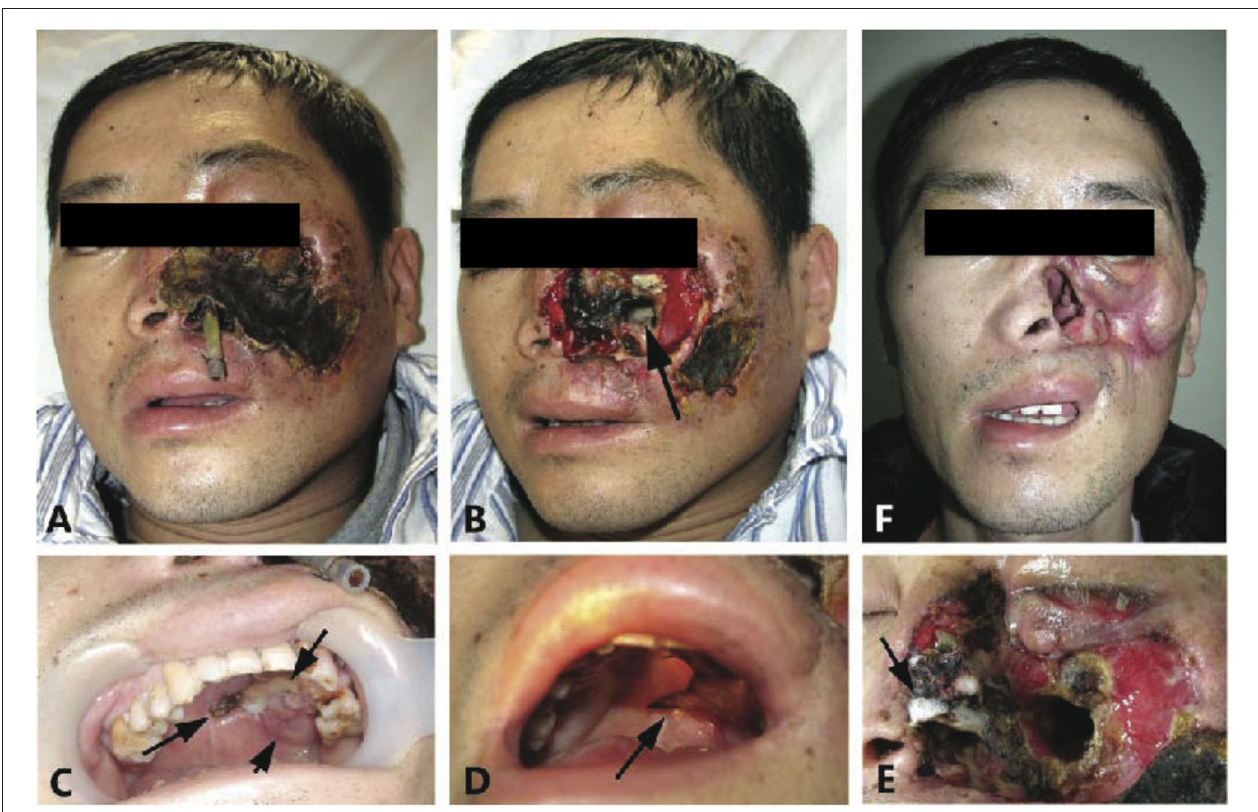
FIGURE 1 | “ Rhizopus arrhizus associated lethal midline granuloma/rhino-orbital cerebral mycosis.” Destruction of the sinus, nose, face, palate, and orbit; defects of the left sided external nose, soft tissues, and the front wall of the maxillary sinus; and yellow pus was seen within the left maxillary sinus. (A,B) Show patient onset before and after debridement with biopsies. (C) Reveals the patches dark discoloration (short arrow), light discoloration (medium arrow), and perforation (long arrow) of the hard palate that represent inflammation, ischemia, and necrosis, respectively. (D) Shows widespread destruction in the left side of the palate (arrow). (E) Reveals pale gray wool-like mycelium grown on the necrotic nose tissue (arrow). (F) Shows complete remission with scars 4 months after antifungal